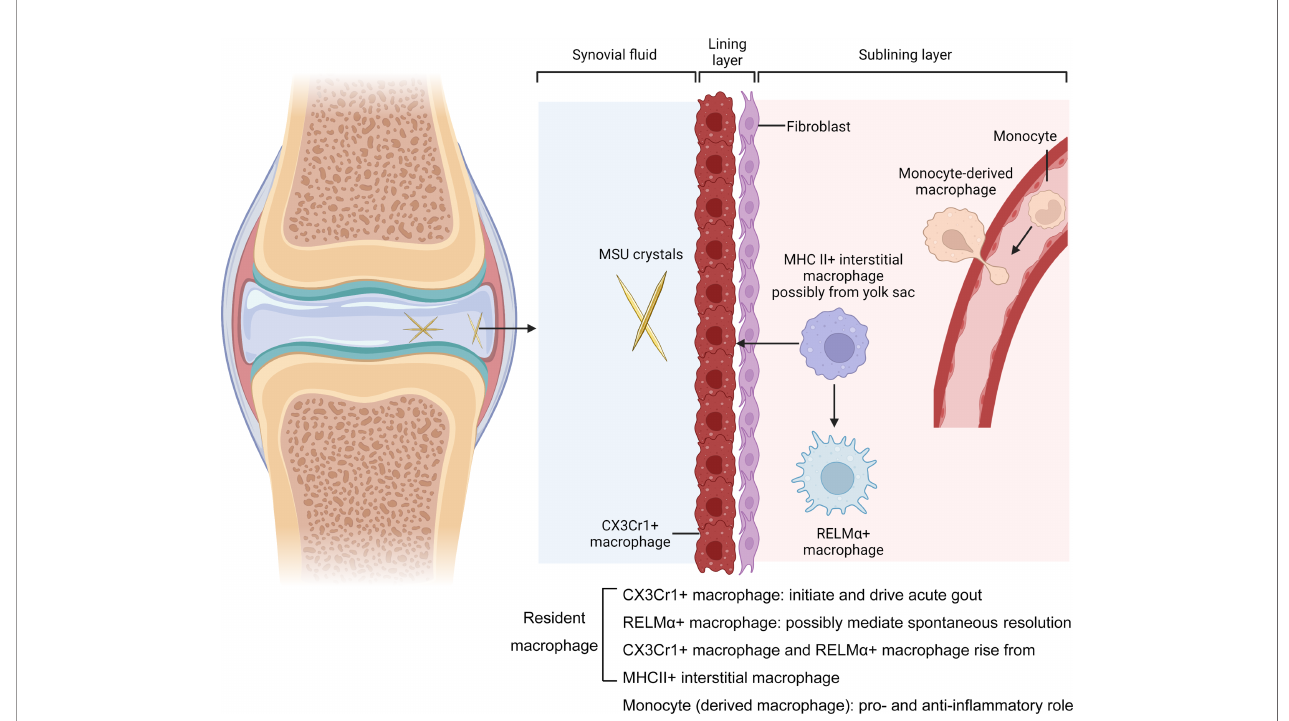
FIGURE 1 | Macrophages in the MSU crytals induced arthritis. Joints are surrounded by a tissue called the synovium, which is formed from layers of cells called the lining and the sublining layers. The resident macrophages in the lining layer highly expressed CX3Cr1 and form a barrier adjacent to a layer of cells called fi broblasts. They initiate and drive acute gout. Barrier-forming macrophages arise from a subpopulation of MHCII + macrophages called interstitial macrophages in the sublining layer. The MHCII + macrophages aslo generate another subset called RELM a + interstitial macrophages. They express genes associated with alternative activation (CD163 + CD206 + ), suggesting an immunosuppressive phenotype that is protective. The other Non-resident macrophages enter the joint from blood vessels. These cells, which can drive and supress MSU crystals induced in fl ammation, derived from monocytes. Mr. Xiangyu Xu and Dr. Lei Liu, created with